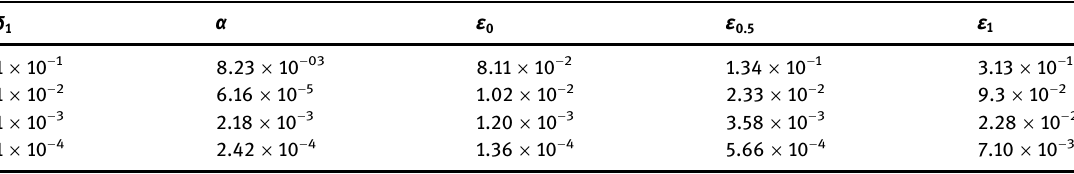
Table 1: Relative errors ε y of Example 1